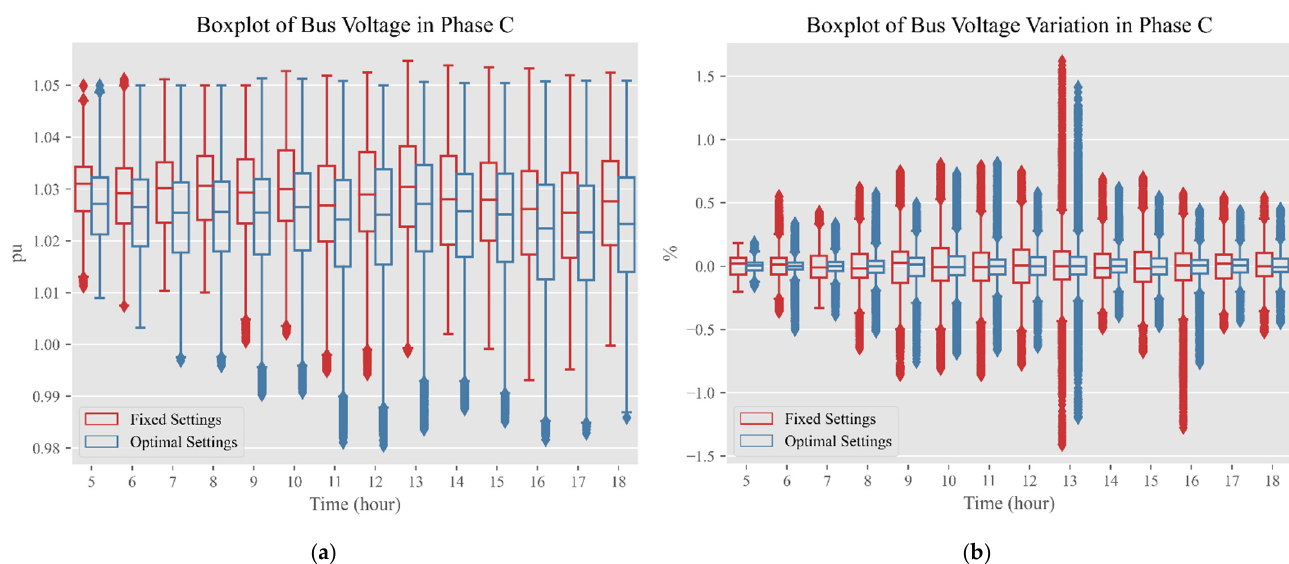
Figure 10. Boxplots of ( a ) bus voltage and ( b ) voltage variation in phase C for each hour with fixed and optimal volt–var control settings.